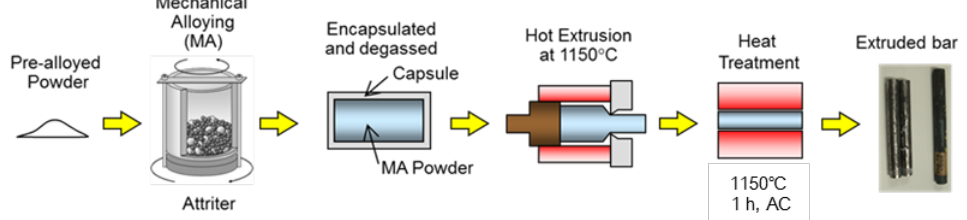
Figure 1. Processing of mechanical alloyed ODS ferritic steels for production of the extruded bar. Pre-alloyed powder with an addition of Y 2 O 3 powder was mechanically alloyed in an attriter with steel balls for 48 h in Ar. Hot extrusion was performed at 1150 ◦ C, and homogenization annealing was done at 1150 ◦ C for 1 h followed by air cooling. The diameter of the extruded bar was about 25 mm.